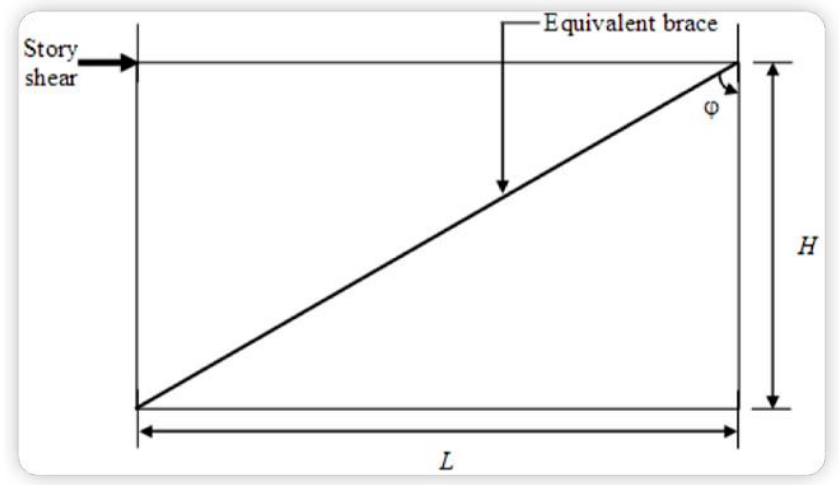
Figure 1. Multistrip Model.